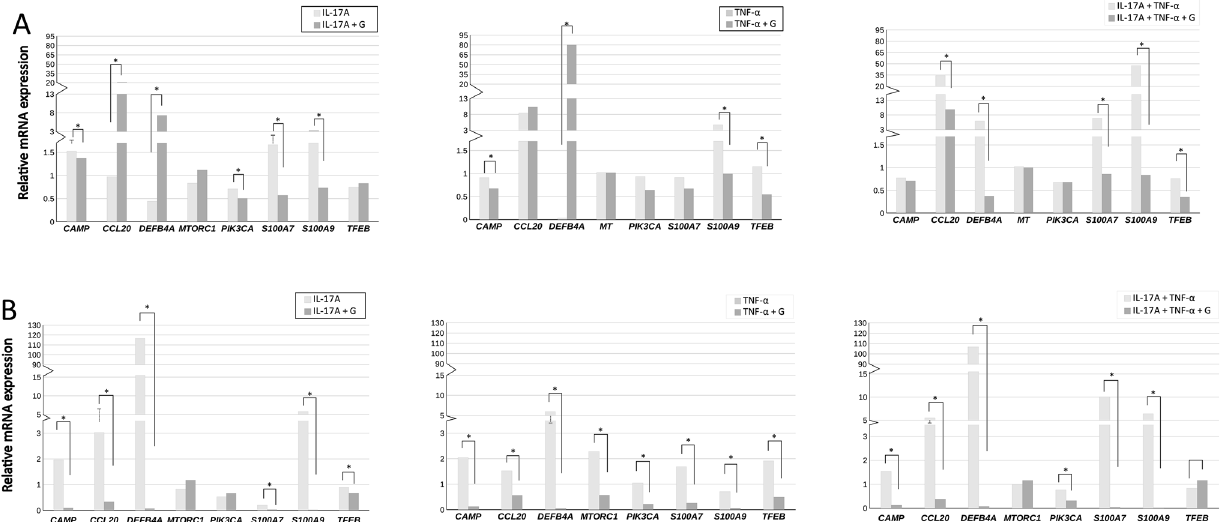
Figure 5. Real-time qRT-PCR verification of selected genes related to the early inflammatory response characteristic of psoriasis ( CAMP , CCL20 , DEFB4A , PIK3CA , S100A7 , and S100A9 ), as well as MTORC1 and TFEB genes in HaCaT ( A ) and pKC cells ( B ), after the activation with IL-17A, TNF-α, or an IL-17A/TNF-α mix. Keratinocytes were pretreated with 100 μM of genistein for 1 h and then incubated with IL-17A, TNF-α, or an IL-17A/TNF-α mix for the next 24 h. The relative mRNA expression levels were determined against the TATA-Box Binding Protein ( TBP ) reference gene, and the relative quantitation